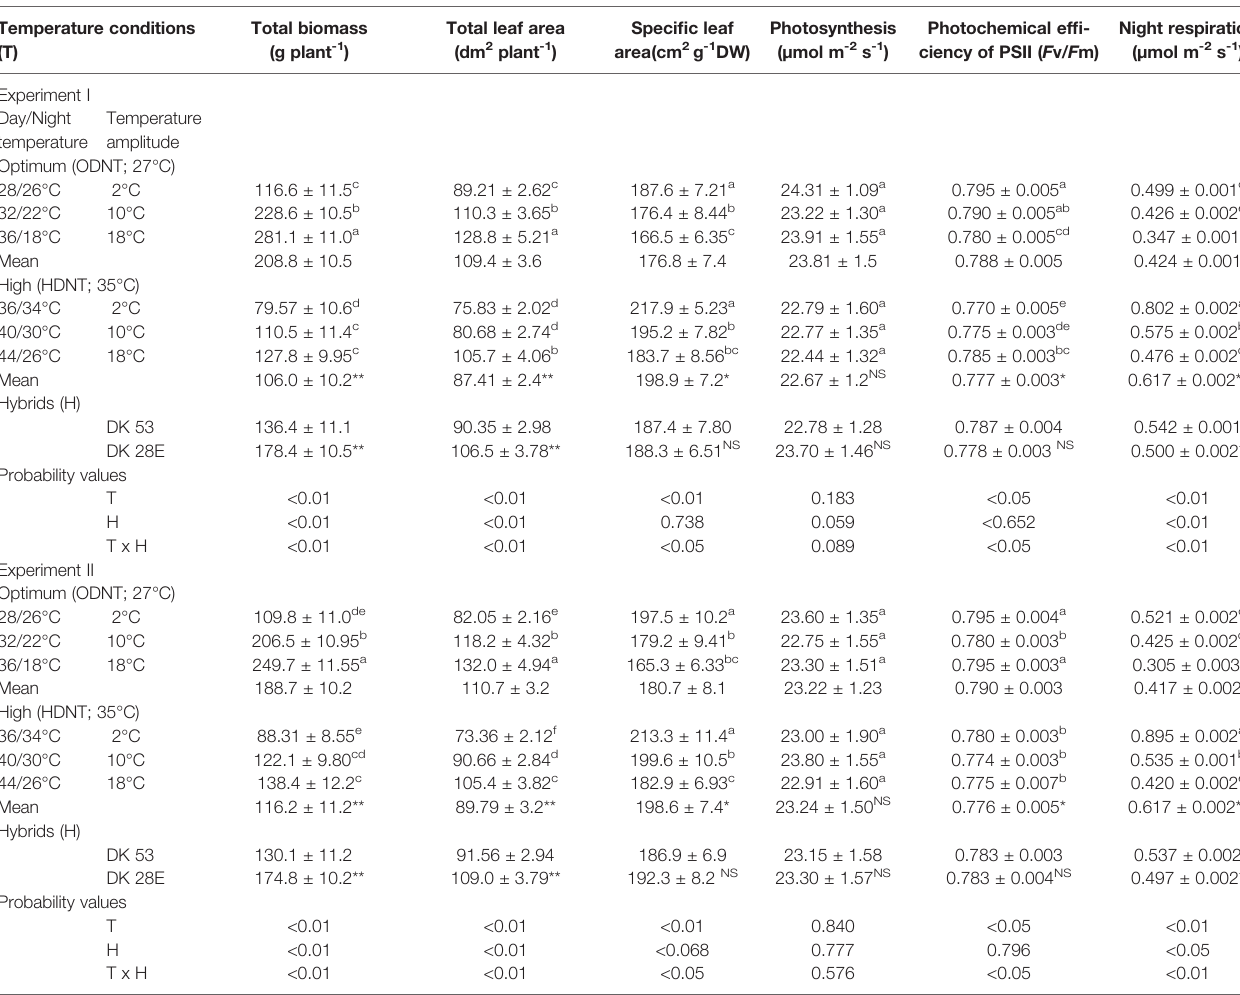
TABLE 1 | Effect of two mean temperatures [27°C (optimum mean daytime and nighttime temperature; ODNT) and 35°C (high mean daytime and nighttime temperature; HDNT)] with three diurnal temperature amplitudes (2, 10, and 18°C) on growth and carbon tradeoff in sorghum hybrids (DK 53 and DK 28E). Temperature conditions